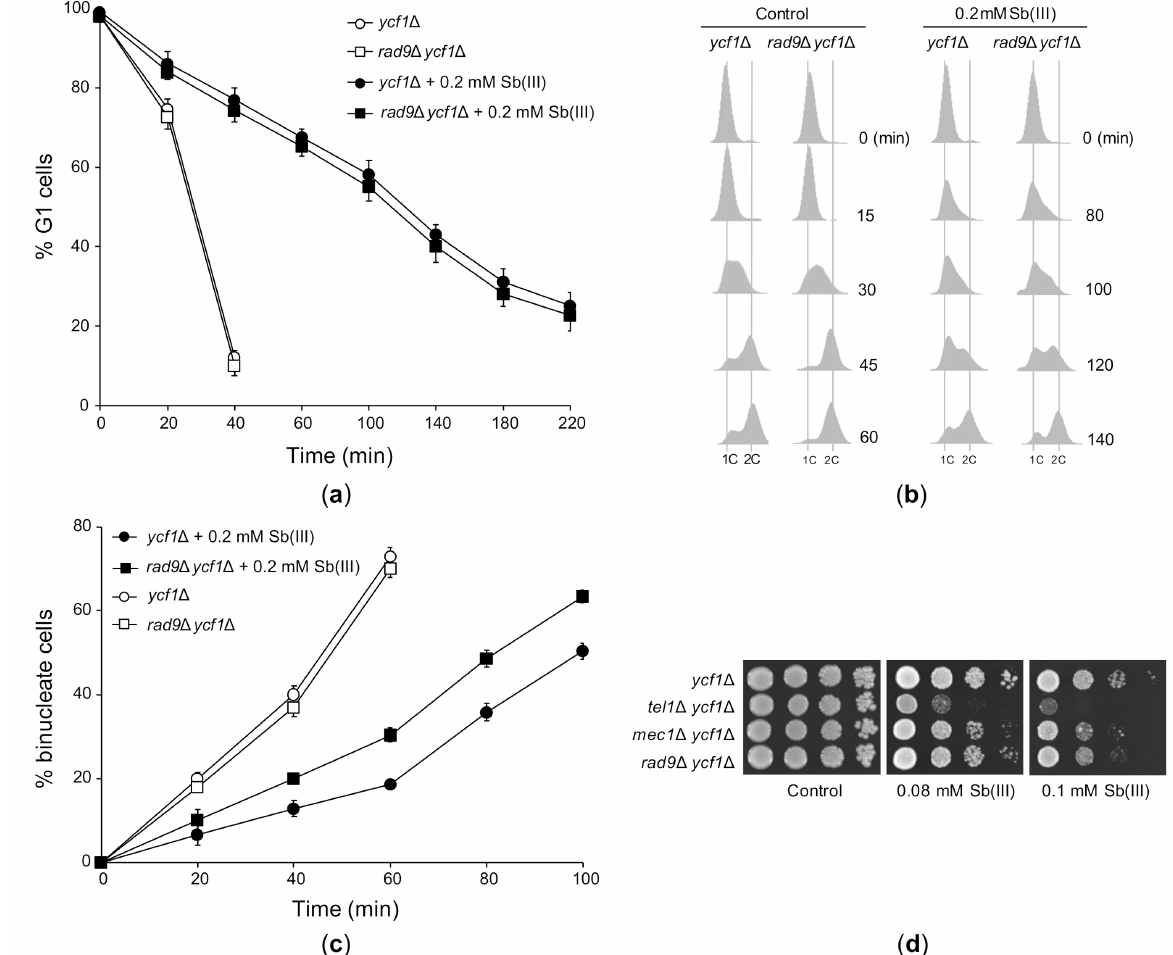
Figure 5. The effect of Sb(III) on cell cycle progression and the role of DNA damage checkpoint pathway in Sb(III) tolerance. ( a ) Sb(III) does not trigger checkpoint-dependent G1 delay. The ycf1 ∆ and rad9 ∆ ycf1 ∆ strains were synchronized in G1 with α -factor, washed and released in the presence or absence of 0.2 mM Sb(III). Percentage of cells arrested in G1 was determined by the α -factor-nocodazole trap assay. ( b ) Sb(III) slows S phase progression, partially in a Rad9-dependent manner. Cells were prepared and treated as described in ( a ). DNA content was determined by flow cytometry. 1C, DNA content. ( c ) Sb(III)-induced G2/M delay partially depends on Rad9. Cells were arrested at G2/M boundary with nocodazole and then released in the presence or absence of 0.2 mM Sb(III). Percentage of binucleate (post-mitotic) cells was determined by fluorescence microscopy. ( d ) Sensitivity of DNA damage checkpoint mutants to Sb(III). Cultures of indicated mutants were serially diluted and plated on rich media in the presence or absence of Sb(III). Plates were incubated at 30 ◦ C for 2 days and then